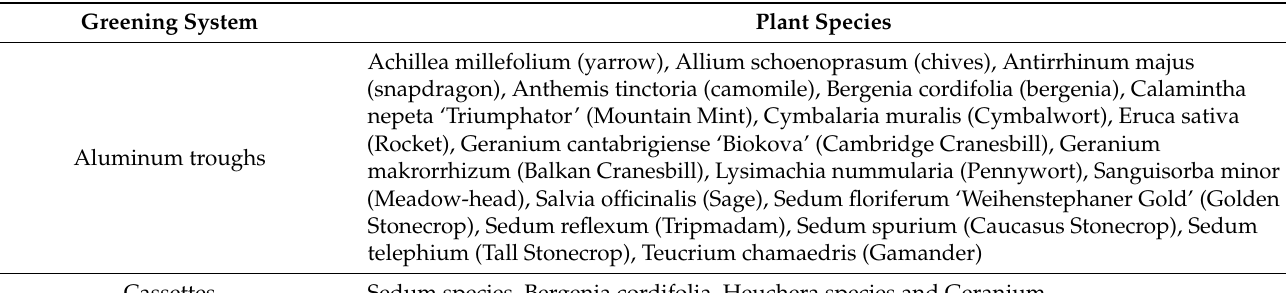
Table A1. Plant species in the studied greening systems. Greening System Plant